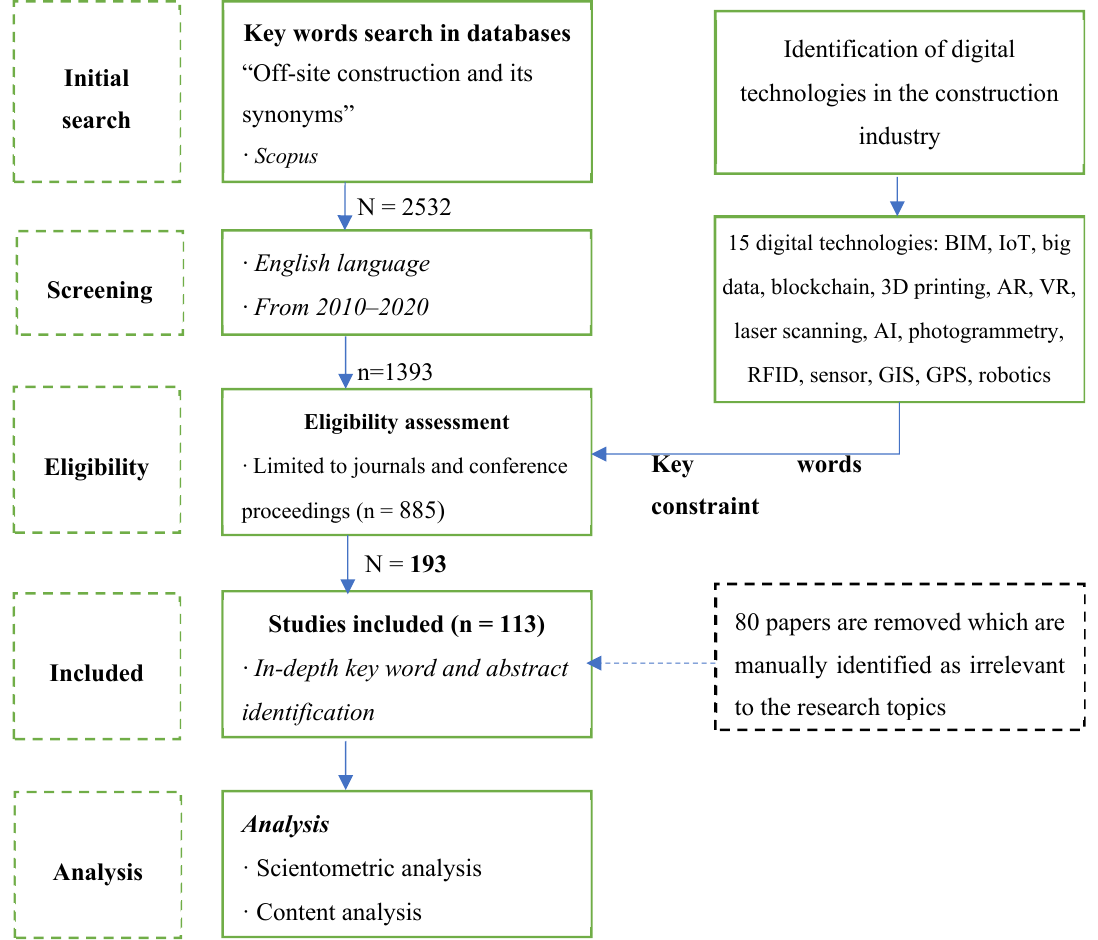
Figure 3. Methodology of conducting the systematic literature review.